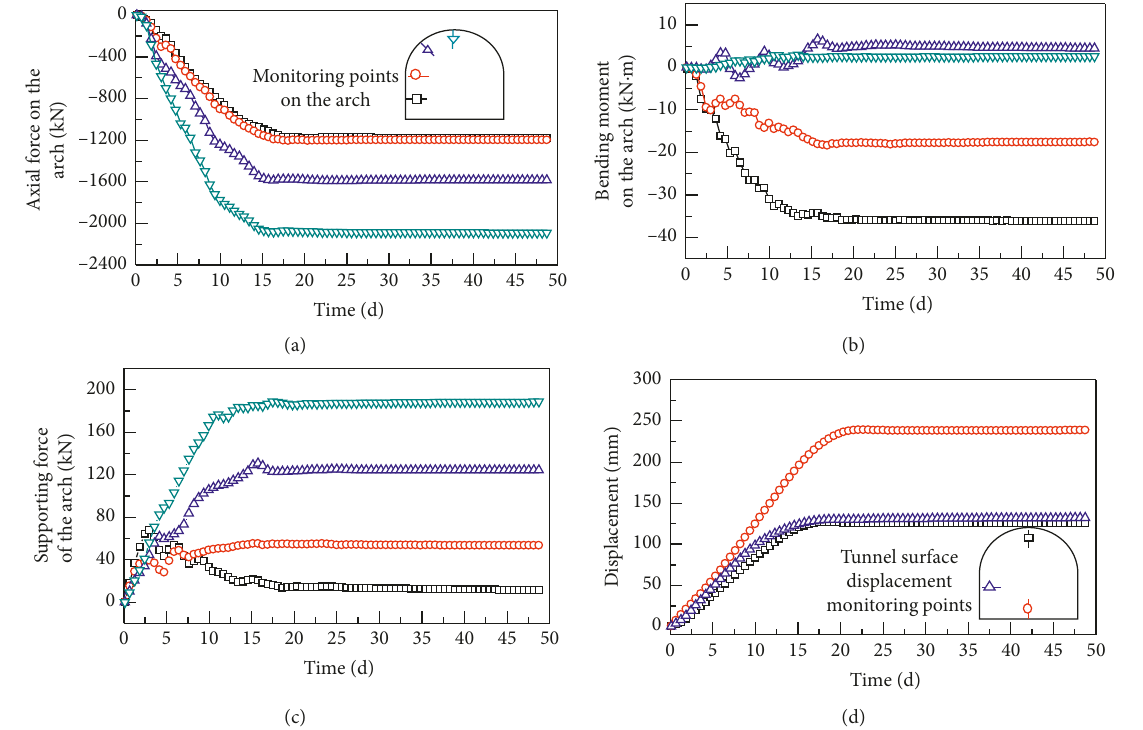
Figure 12: Evolution curves of (a) arch axial force, (b) arch bending moment, (c) arch supporting force, and (d) roadway displacement of Scheme 13.